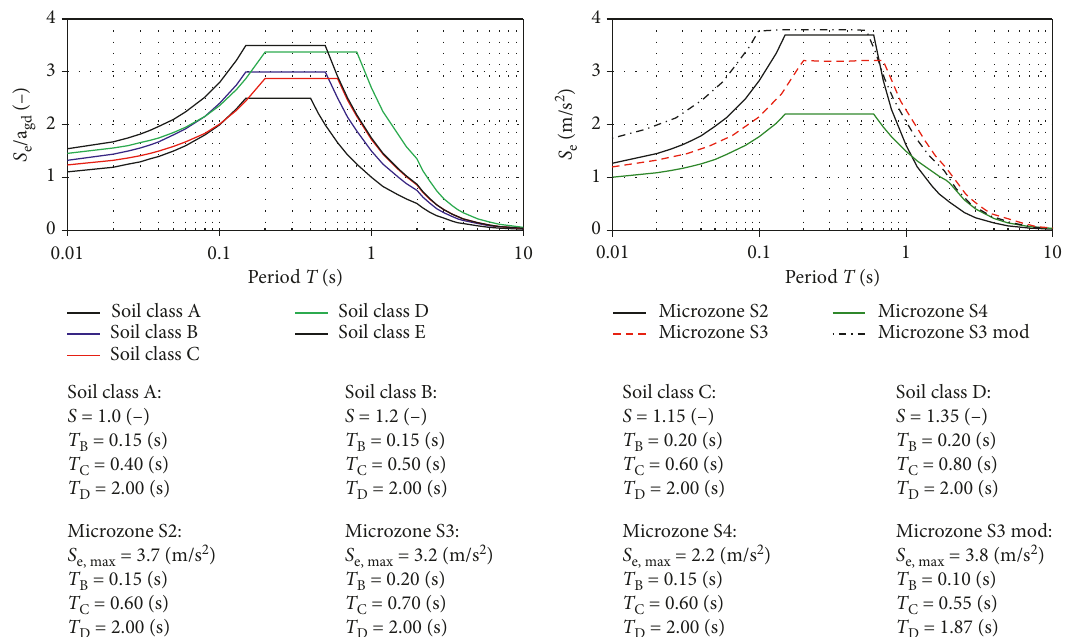
Figure 3: Eurocode 8: elastic response spectra for 5% damping ratio related to the soil classes A to E microzonation of Yverdon: elastic response spectra for a return period of 475years and 5% damping ratio related to the four microzones S2, S3, S4, and S3 mod, respectively.